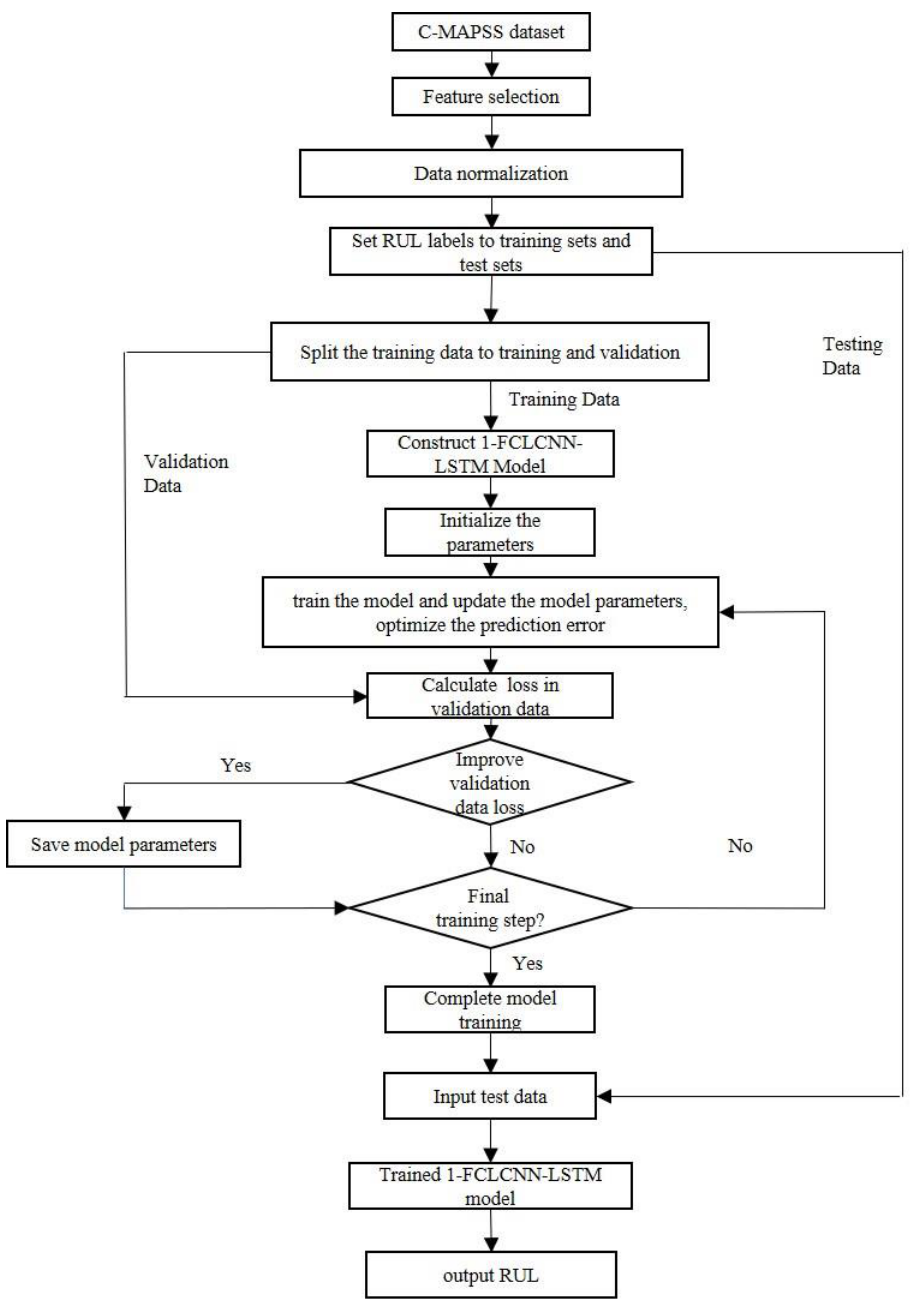
Figure 7. The flow chart of the proposed method.